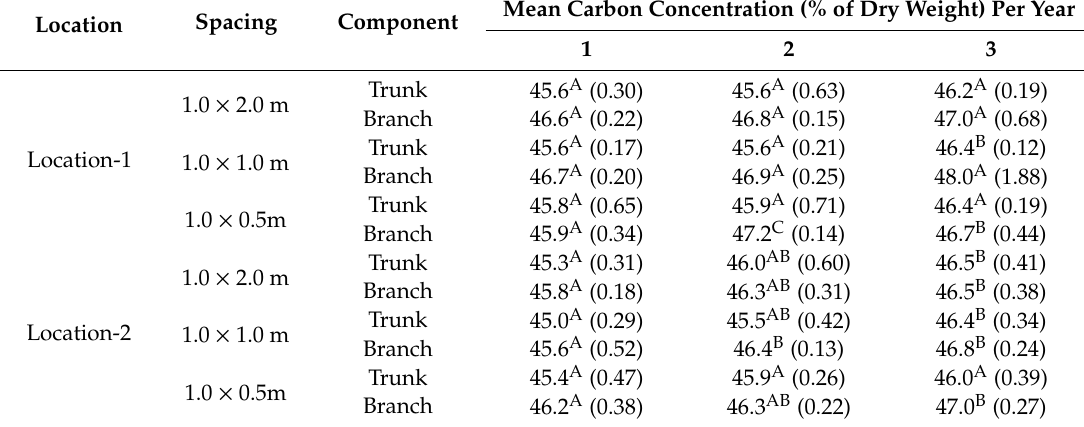
Table 5. Carbon concentration determined in the laboratory per year in each part of the tree in short rotation Gmelina arborea plantations in two di ff erent locations in Costa Rica.